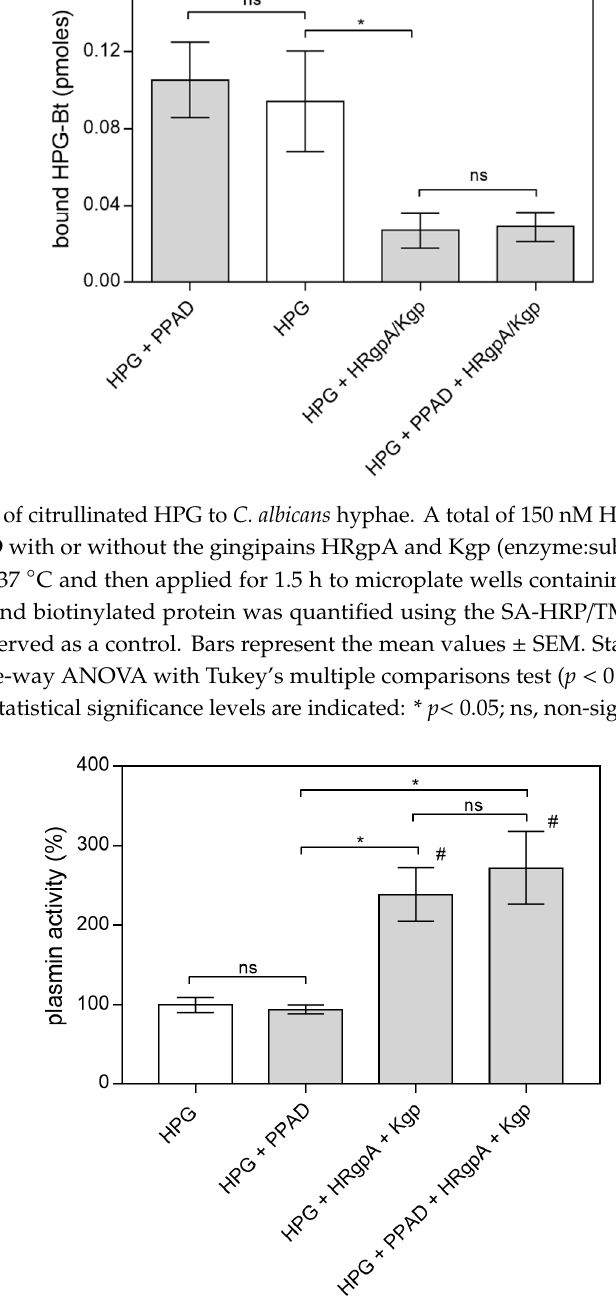
Figure 7. Conversion of HPG into active plasmin by HRgpA and Kgp in the presence of PPAD. A total of 300 nM HPG was incubated with 3 nM HRgpA and Kgp and 100 nM PPAD for 2 h at 37 ◦ C. The gingipain inhibitors KYT-1 and KYT-36 were then added at a final concentration of 1 µ M and the resulting plasmin activity in the presence of plasmin substrate was followed by monitoring the absorption of the released p-nitroaniline at 405 nm. Bars represent the mean values ± SEM. Untreated HPG served as a control. Statistical analysis was performed by one-way ANOVA with Tukey’s multiple comparisons test ( p < 0.05) using GraphPad Prism. Statistical significance levels are indicated: * p < 0.05; ns, non-significant; # p < 0.05 vs. control.